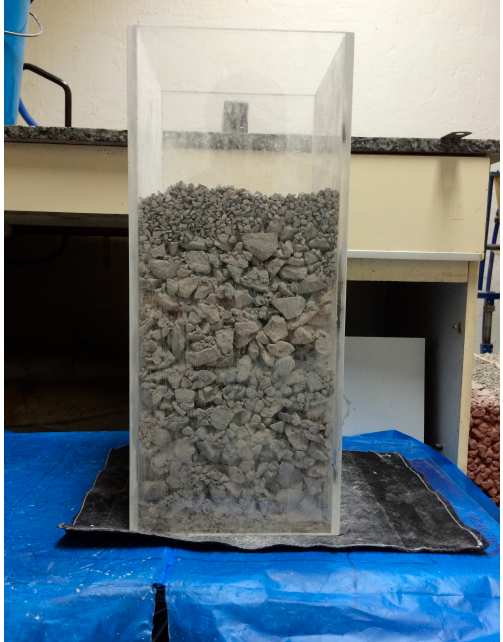
Figure 8. Acrylic container that contains the layers of pervious pavement to be tested.